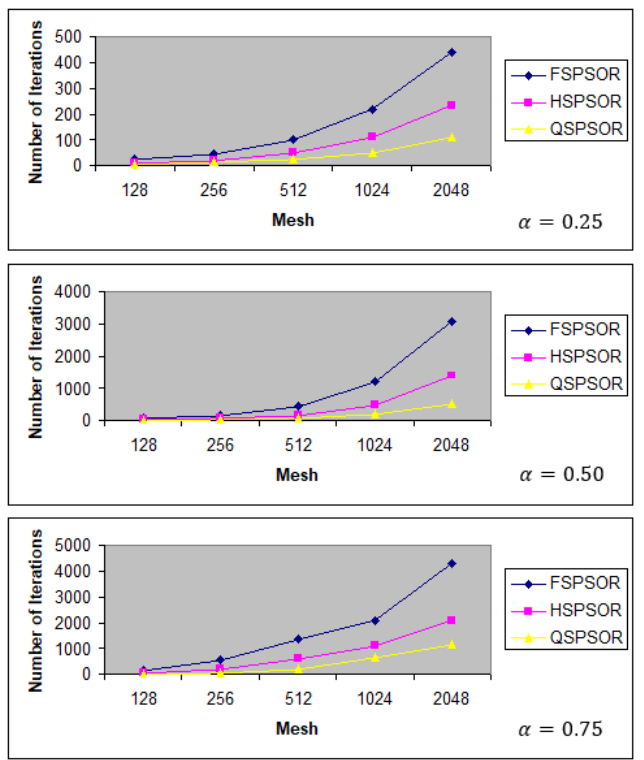
Figure 3. Graphs of performance of FSPSOR, HSPSOR, and QSPSOR methods to solve Example 2, showing mesh sizes versus number of iterations at three different fractional orders.